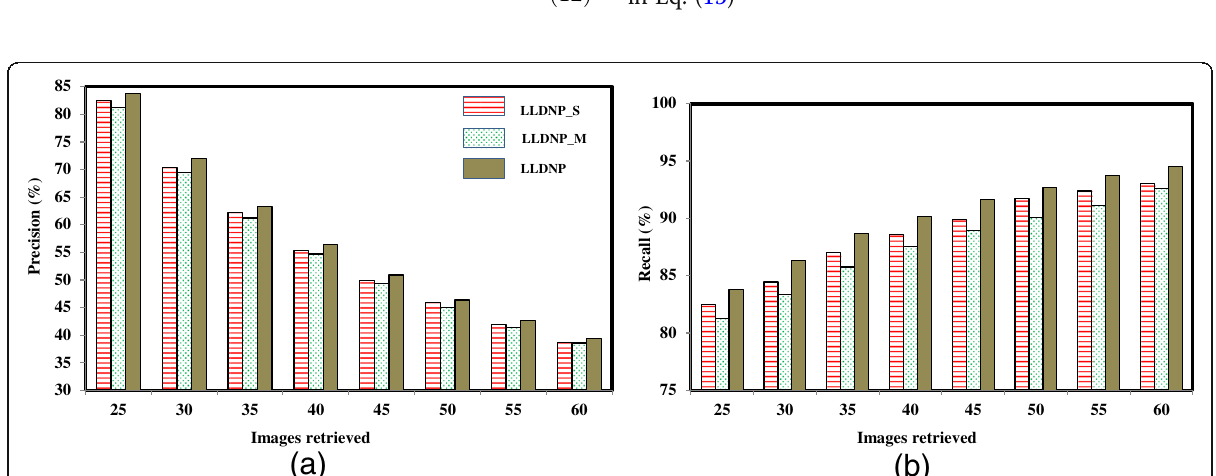
Fig. 5 .Comparison of LLDNP_S, LLDNP_M, and LLDNP in terms of a precision and b recall on Brodatz database. The performance of LLDNP_S is better than LLDNP_M. But LLDNP shows higher performance than LLDNP_S and LLDNP_M in terms of precision and recall on Brodatz database